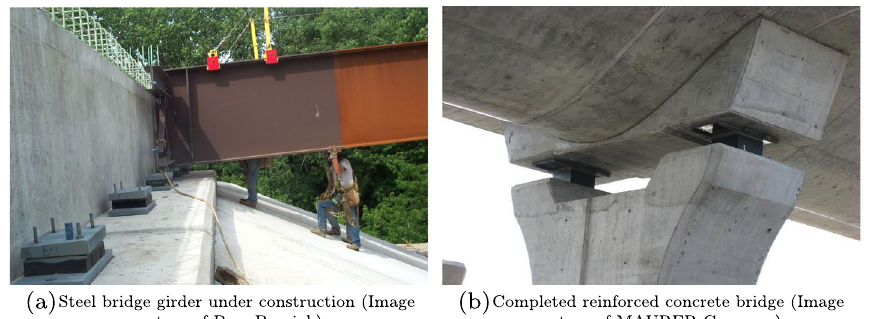
Fig. 1 Elastomeric bearings installation in bridge structures